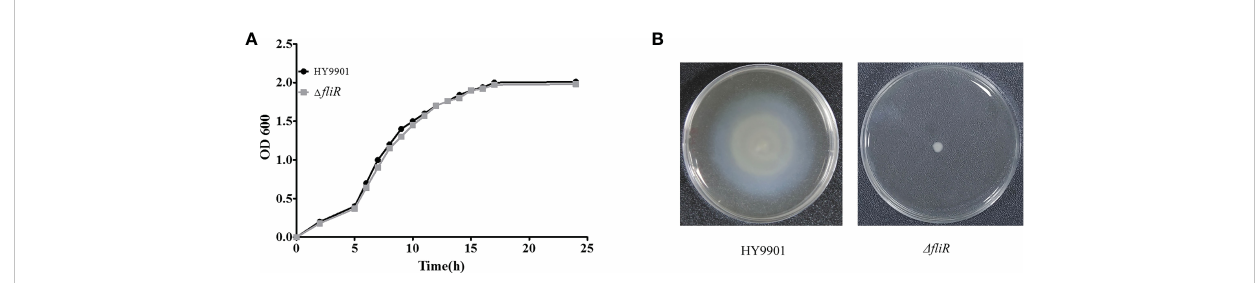
FIGURE 2 The biological properties of V. alginolyticus HY9901 compared with the fl iR mutant strain. HY9901 and mutant strain growth curves (A) , values of OD600 of the bacterial suspensions were measured at different time points. Motility measurements. The swarming diameter of the wild-type strain was about 35 mm, and that of the mutant strain was 3 mm (B) .